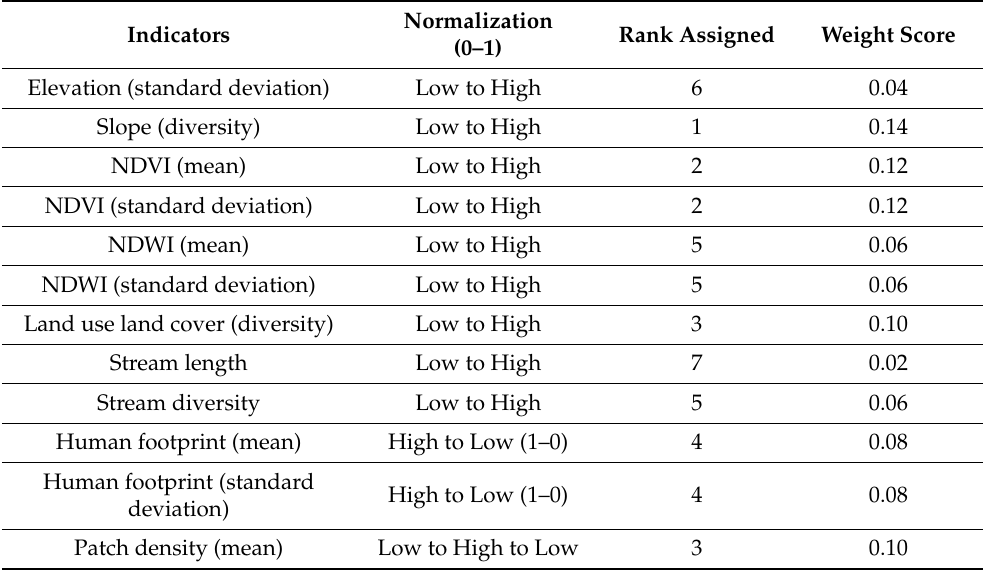
Table 2. Rank and weight score assigned to the variables used in the computation of biodiversity